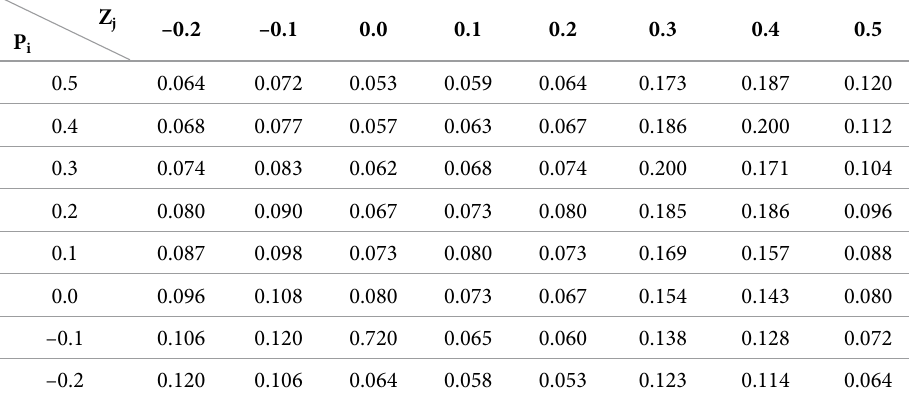
Table 2. Plumbing in reconstruction of buildings in